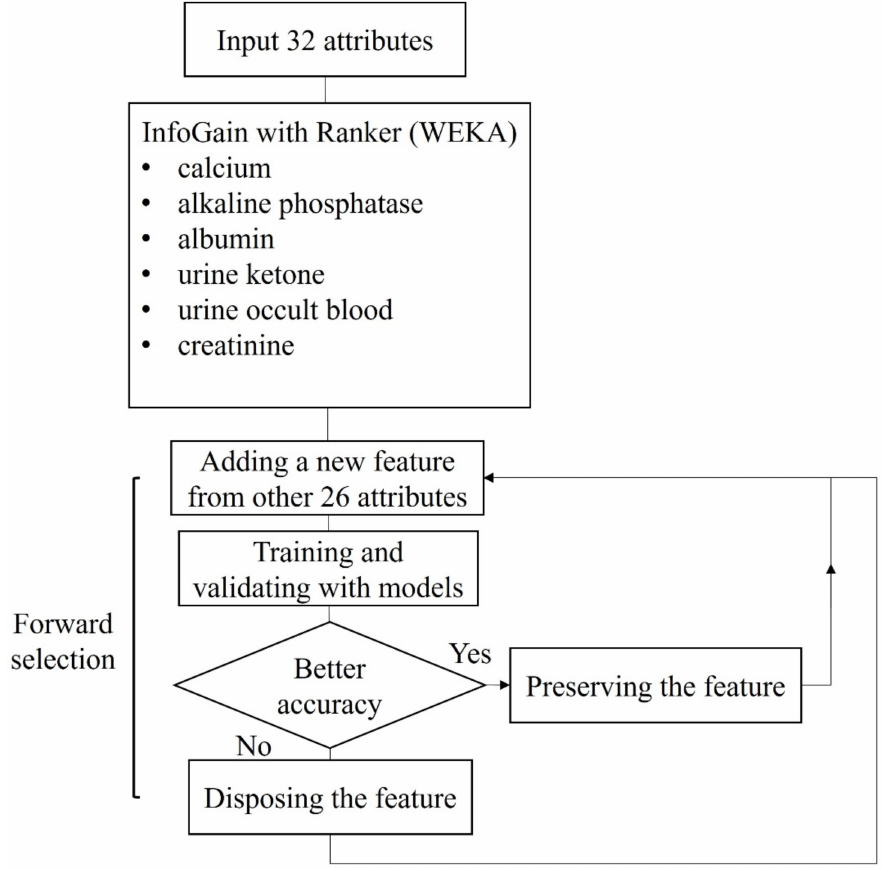
Figure 3. The block diagram of the forward selection method. Table 6. Predictive performance of five models in discriminating patients with bladder cancer from patients with